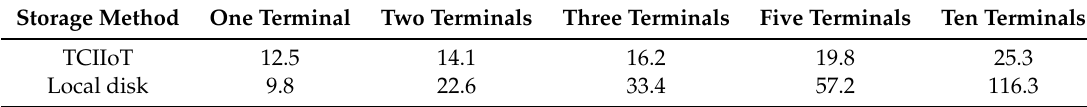
Table 5. The disk usage comparison with the increasing of terminals (GB).